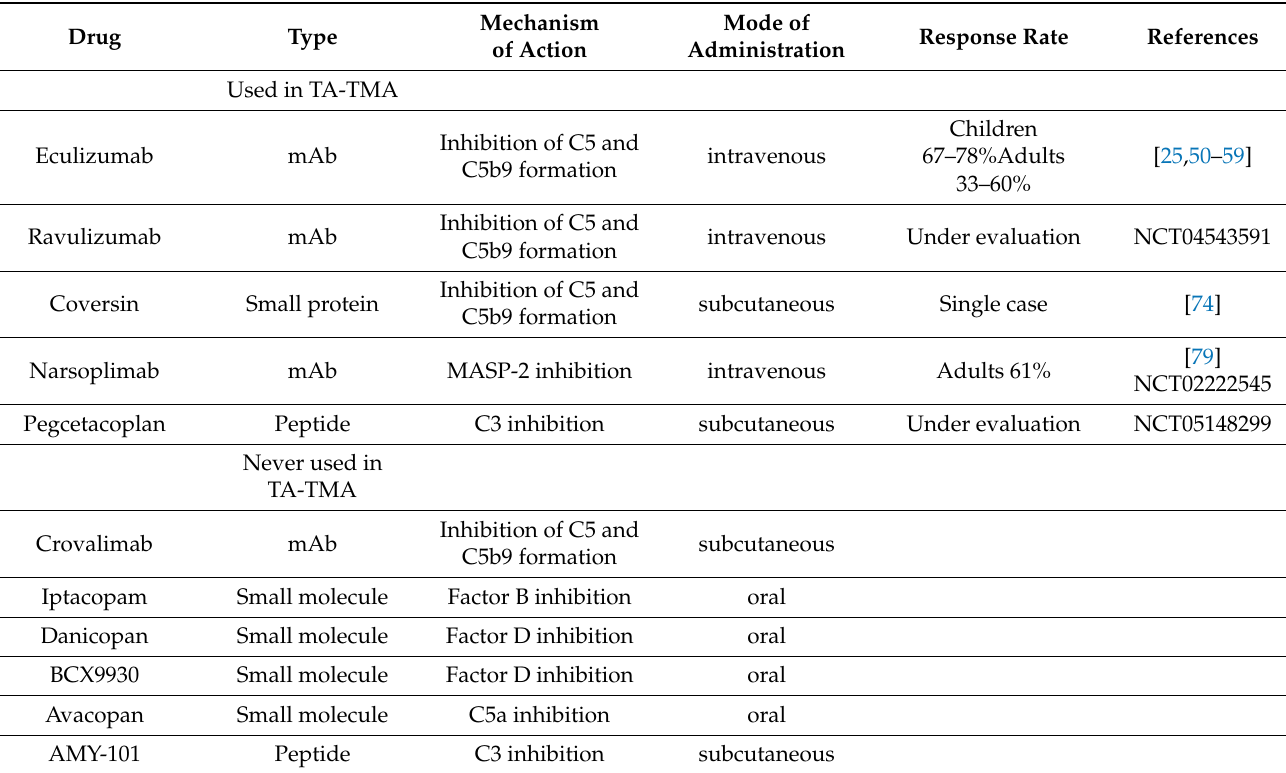
Table 3. Complement targeting drugs used in transplant-associated thrombotic microangiopathy (TA-TMA) or potentially